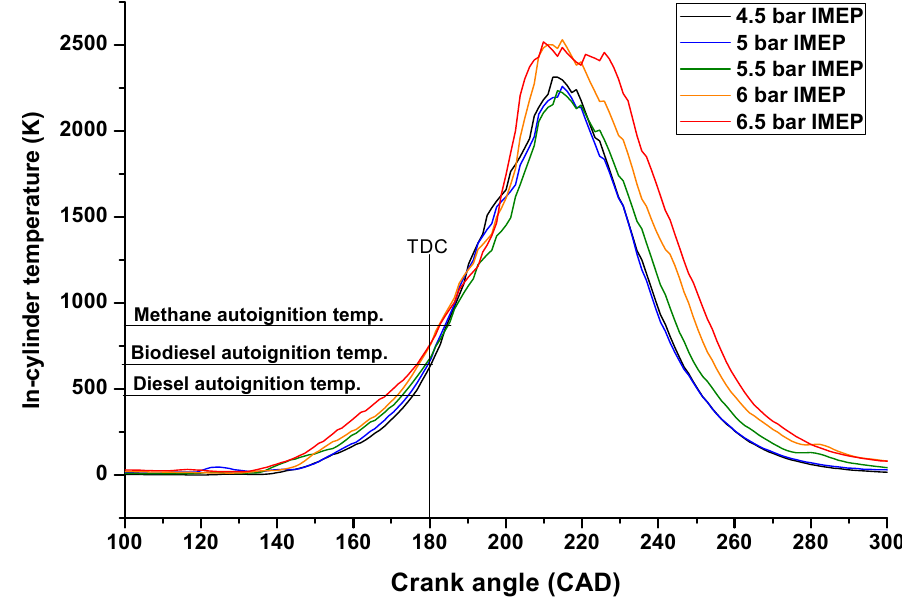
Figure 5. In-cylinder temperature for the combustion of B5/biogas injected at valve for various loads.